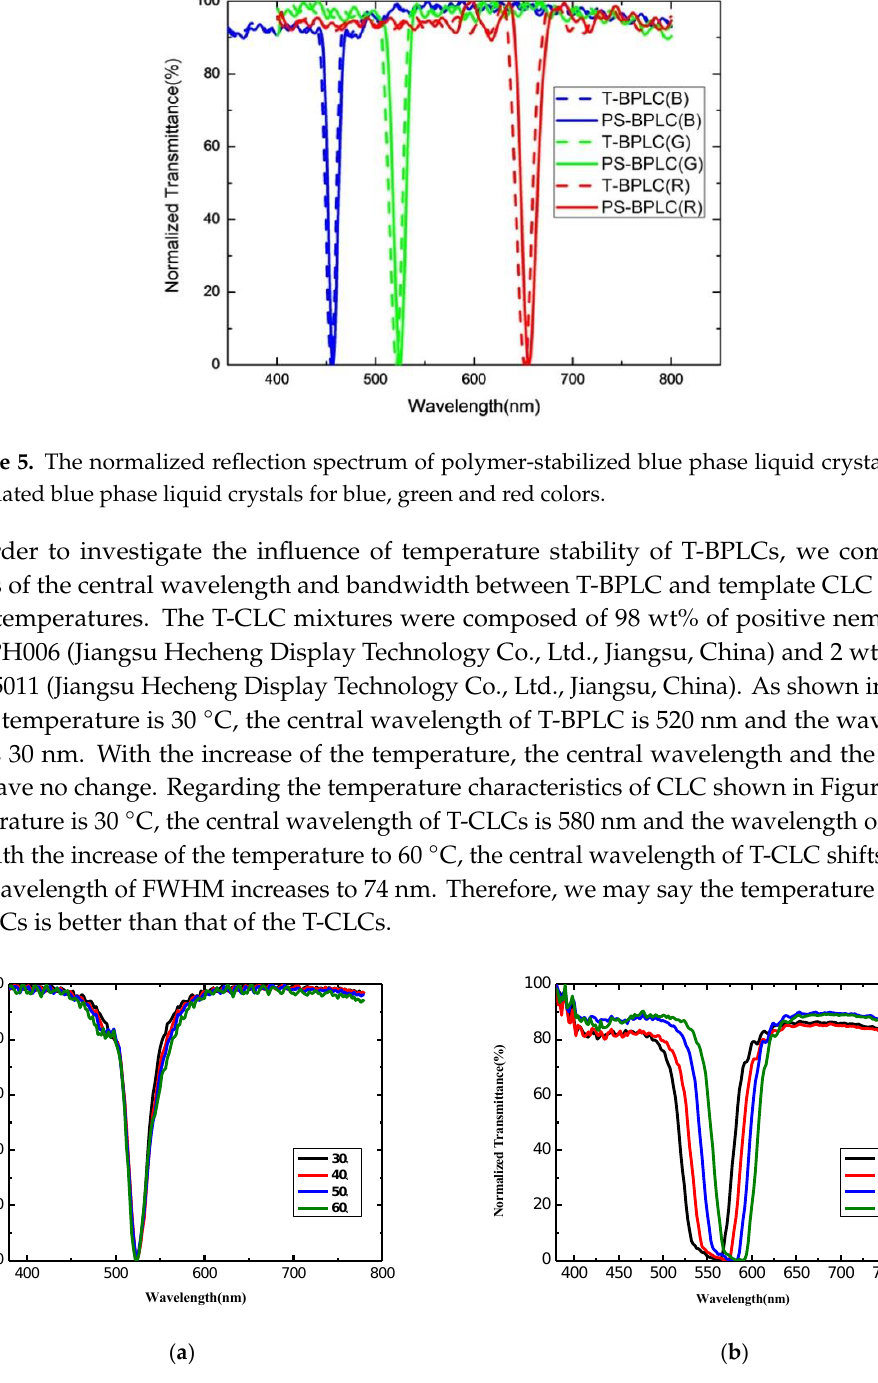
Figure 6. Central wavelength variation of ( a ) templated blue phase liquid crystals and ( b ) templated cholesteric liquid crystals in green color.